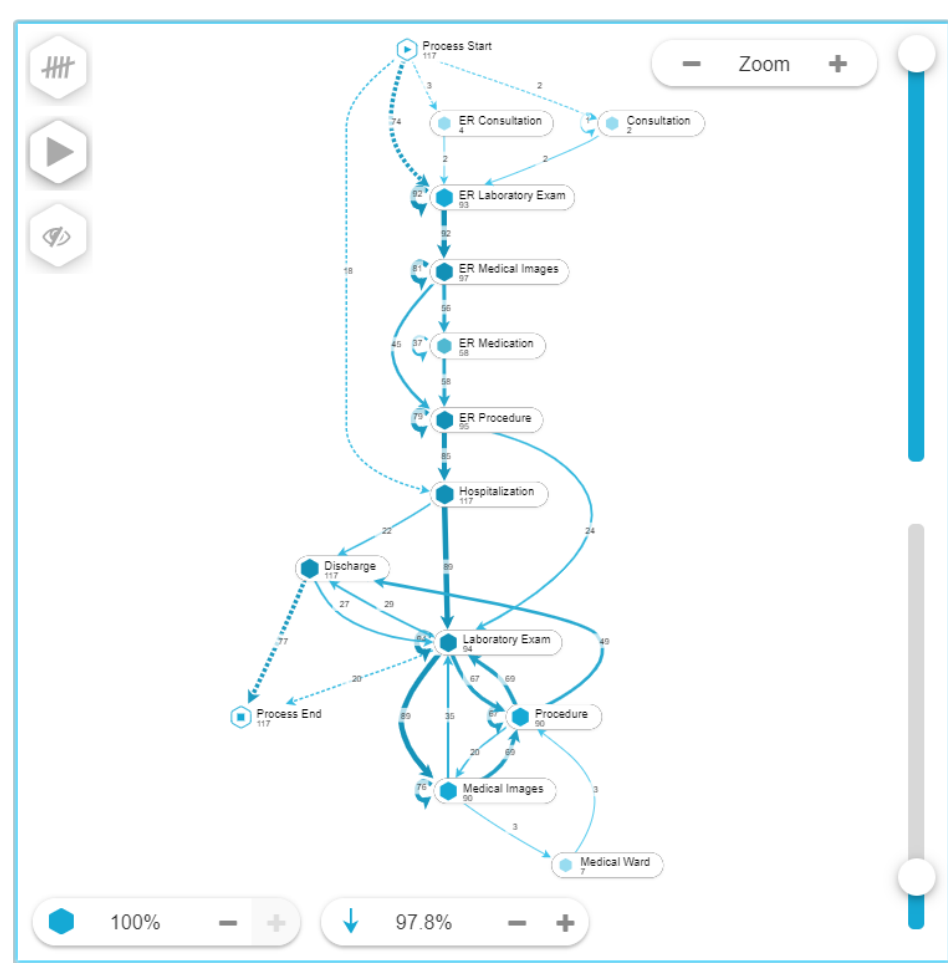
Figure 9. AMI patients’ journey map.